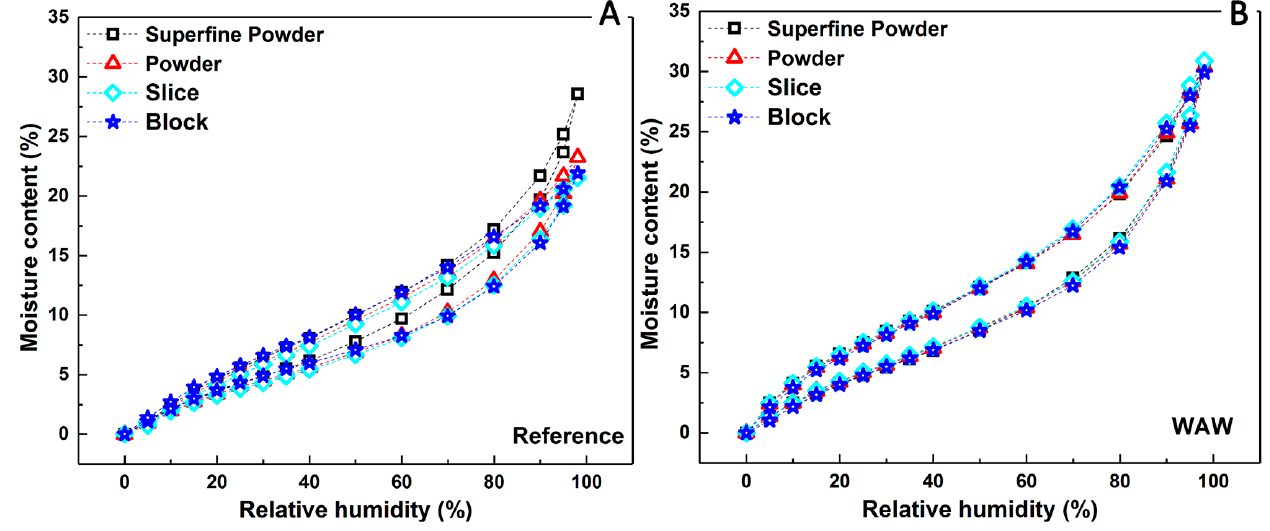
Figure 2. Equilibrium moisture content (EMC) sorption isotherms of the reference samples ( A ) and WAW samples ( B ) versus relative humidity (RH) ranging from 0 to 98%.